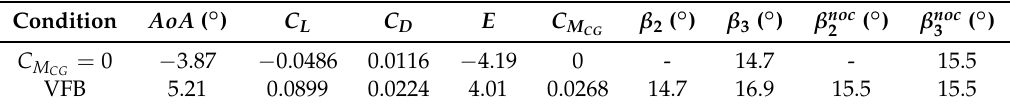
Table 6. Aerodynamic parameters and shock wave angles for the zero pitching moment ( C M and Vertical Force Balance (VFB) conditions of the analytical